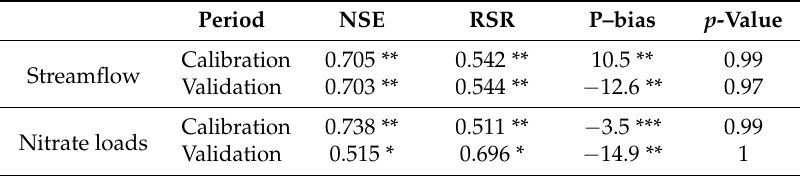
Table 4. Model performance measures for monthly streamflow and nitrate loads.